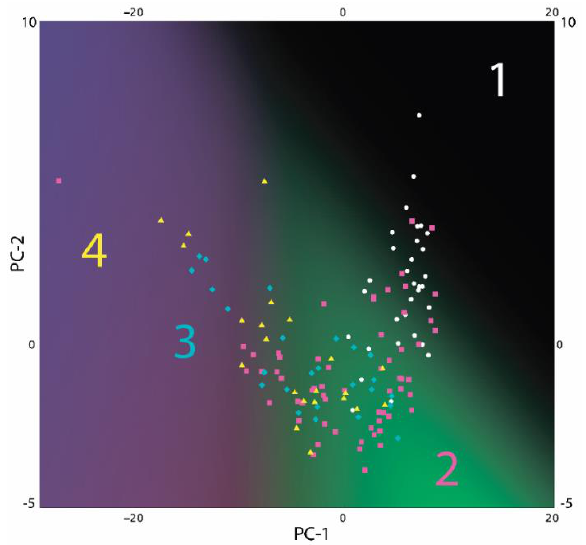
Figure 2. 2D probability distribution of each class as a function of the studied subjects: 1 — brefomatrix from spongy bones, 2 — brefomatrix from cortical bones, 3 — biomaterials from dentin of juvenile teeth with demineralization in 1.2 Н, 4— biomaterials from dentin of juvenile teeth with demineralization in 1.8 Н .